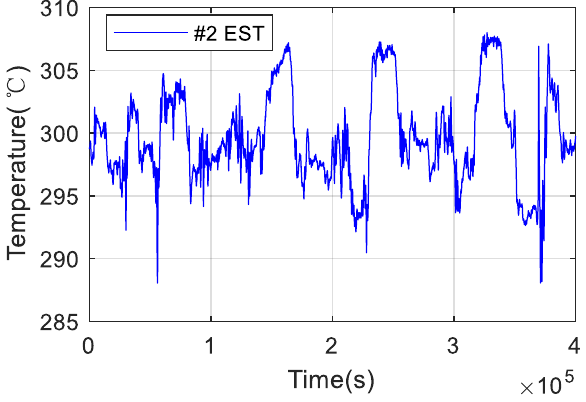
Figure 9. The #2 EST temperature duration curve.